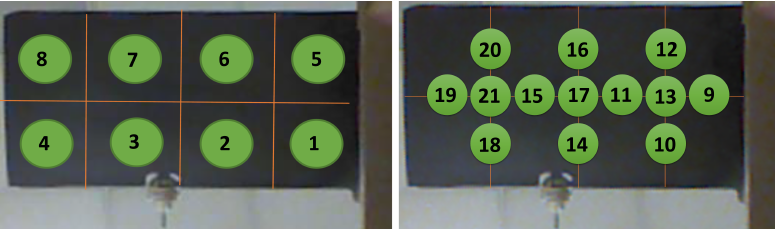
Figure 4. Positions of concentrated ( Left ) and distributed ( Right ) loads (Green) acting on the UAV